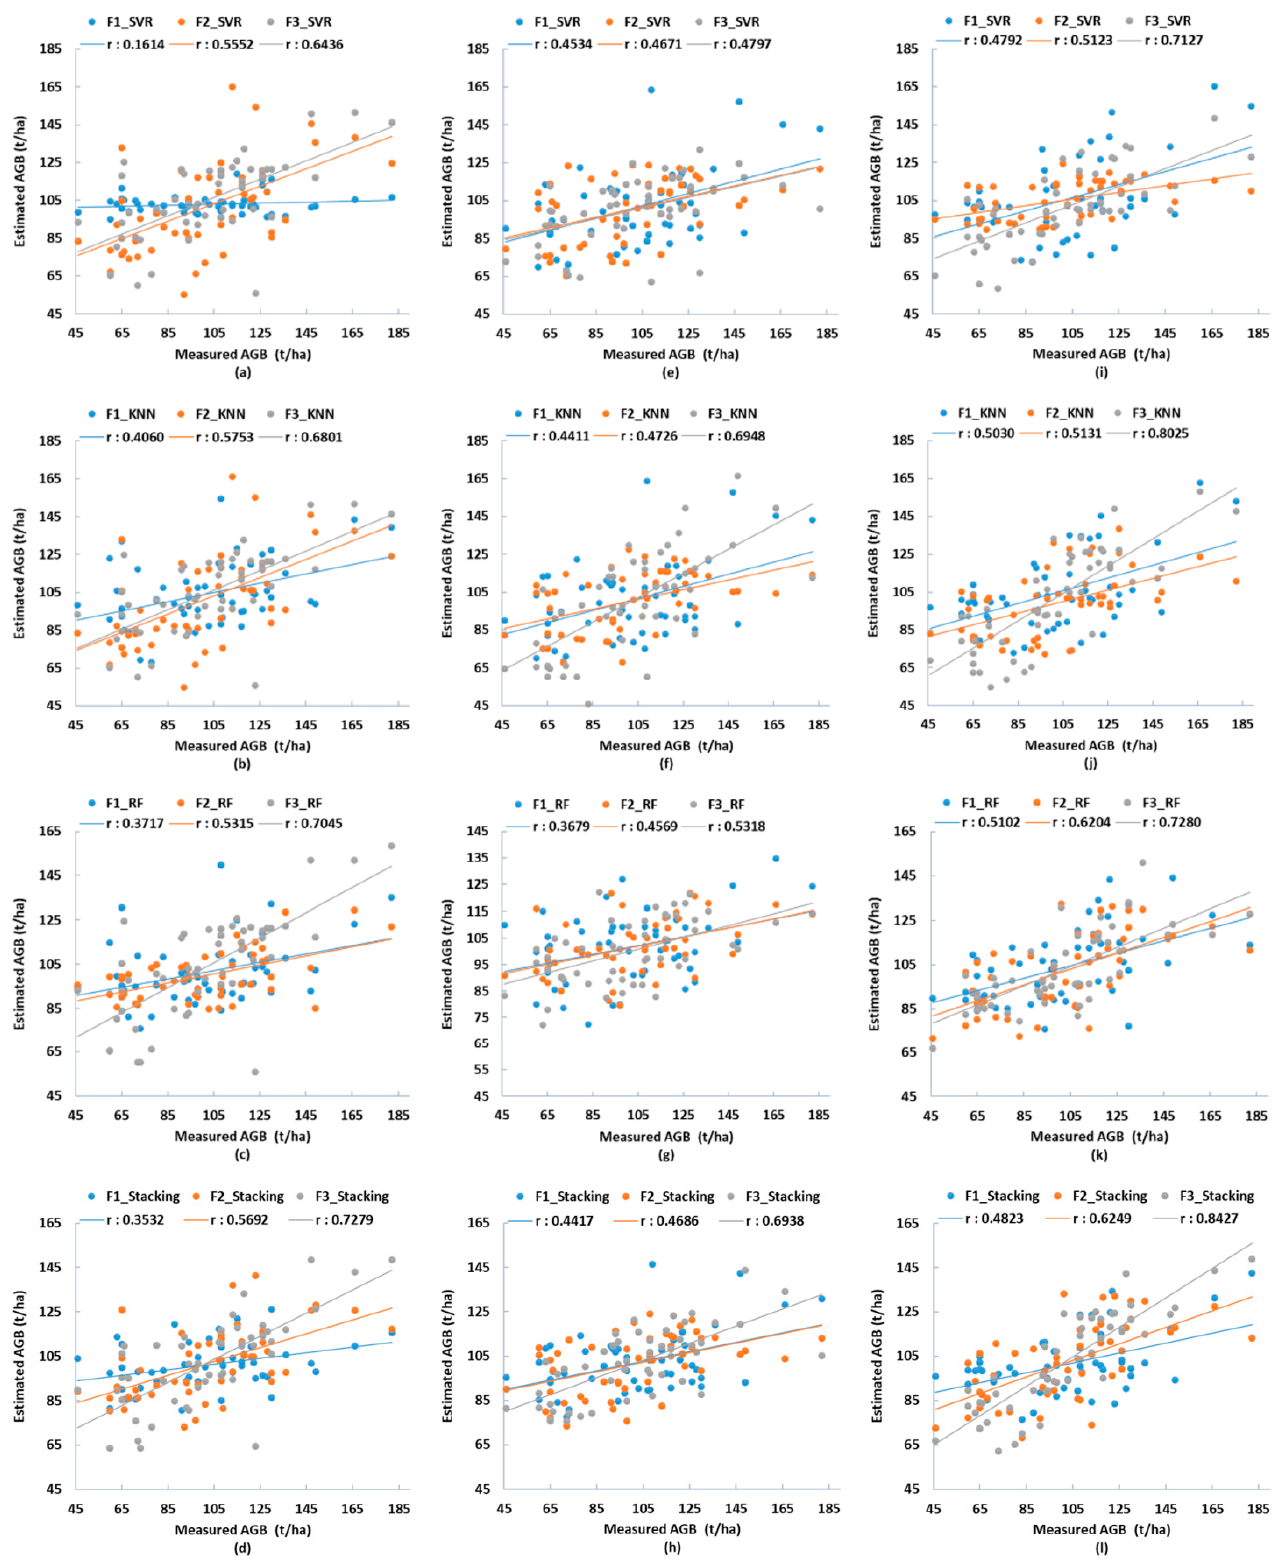
Figure A5. The scatter graphs between the observed and estimated AGB values of the Chinese fir plots using three image datasets and four estimation models: ( a – d ), ( e – h ) and ( i –l) are the AGB estimated by the GF-2, Sentinel-2, and NND_B3 image using the SVR, KNN, RF, and stacking algorithm, respectively. Blue, orange, and gray represent F1, F2, and F3 feature variable sets, respectively.